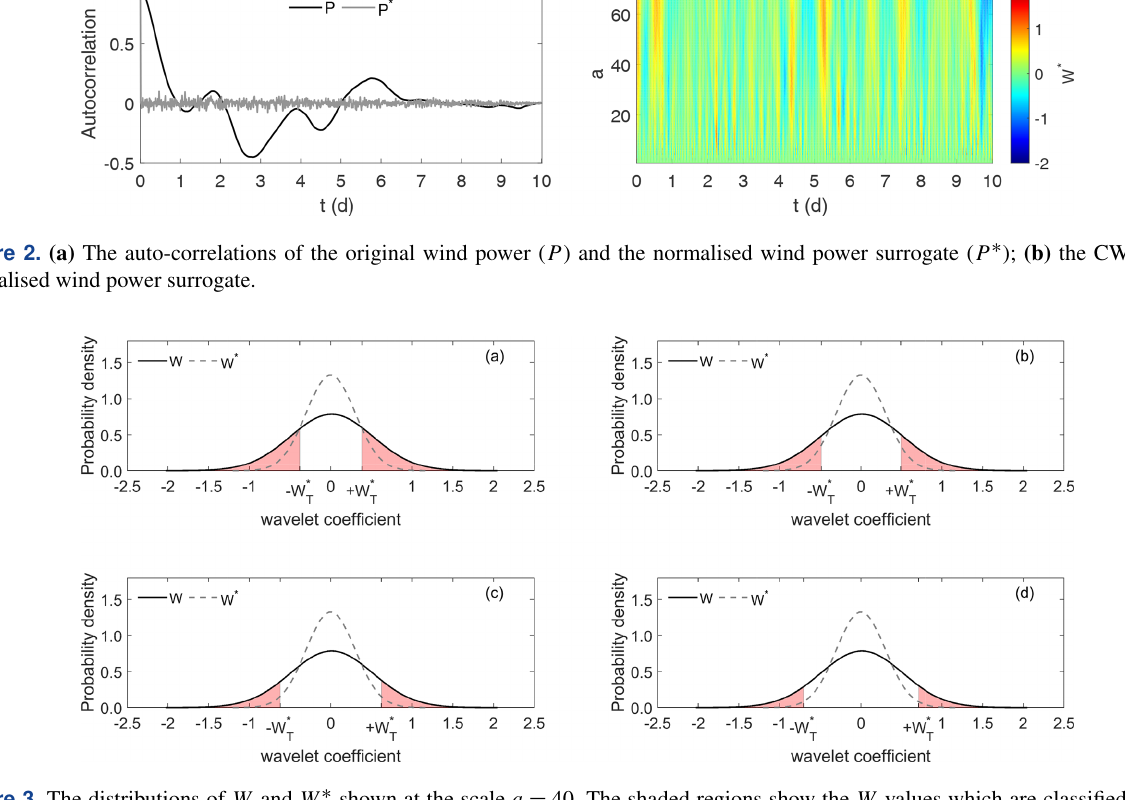
Figure 3. The distributions of W and W ∗ shown at the scale a = 40. The shaded regions show the W values which are classified as ramp events based on thresholds ± W ∗ set using the highest (a) 10%, (b) 5%, (c) 2%, and (d) 1% of the W ∗ T